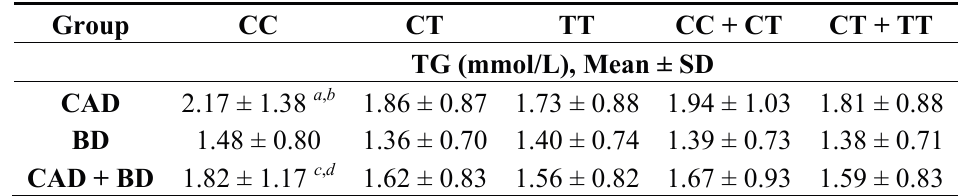
Table 4. Triglyceride (TG) serum levels in regard to genotypes of USF1 gene, rs2516839